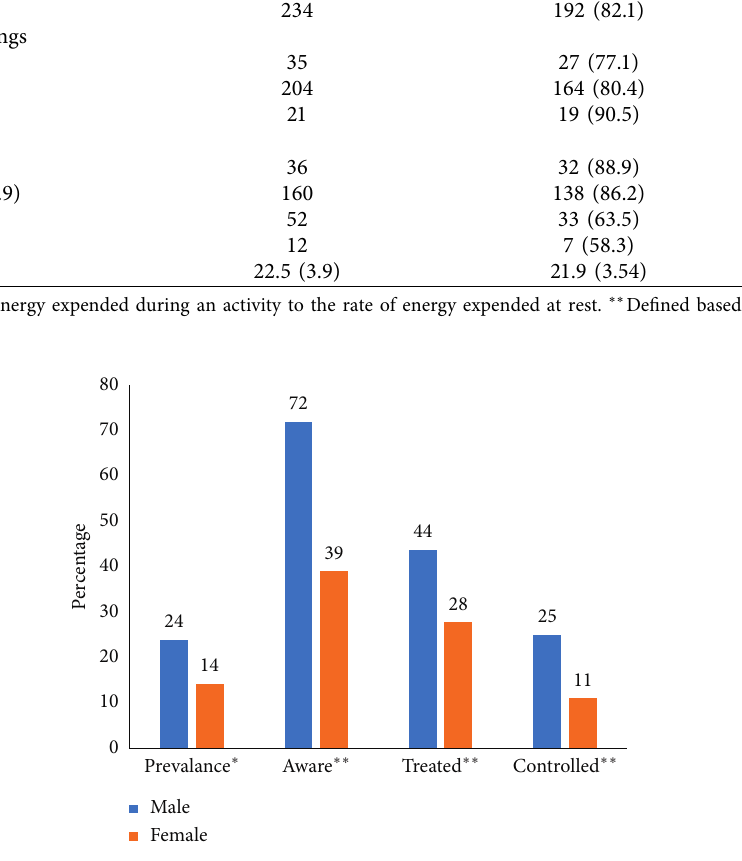
Figure 2: Hypertension prevalence, awareness, treatment, and control by gender. ∗ N � total study population (260, 134M and 126F); ∗∗ N � hypertensive (50, 32M and